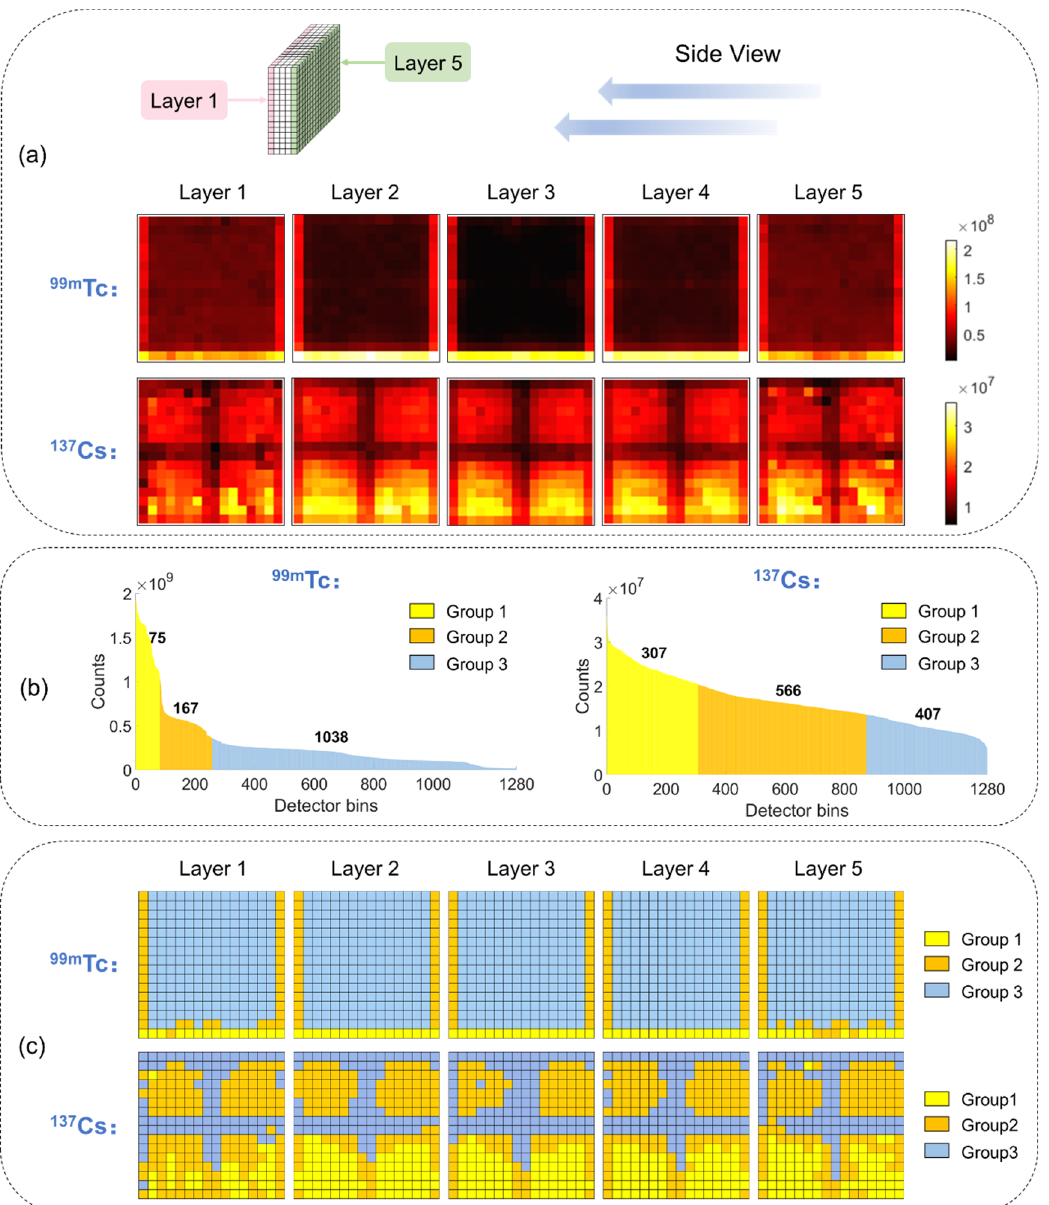
Figure 5. ( a ) Sensitivity maps of detector bins for 99m Tc and 137 Cs sources. ( b ) Histogram of total counts of DRFs for each detector bin and grouping results for 99m Tc and 137 Cs sources. ( c ) The position maps of detectors in each data group for 99m Tc and 137 Cs